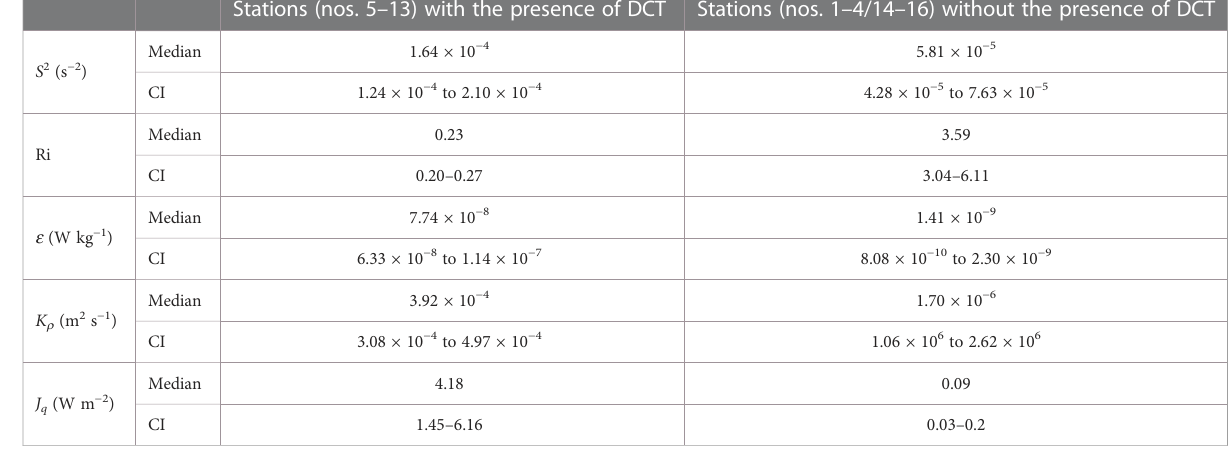
TABLE 1 Median values and 95% bootstrapped con fi dence intervals (CI) of shear variance ( S 2 ), Richardson number (Ri), TKE dissipation rate ( e ), diapycnal diffusivity ( K r ), and turbulent heat fl ux ( J q ) over 0 – 10 m below the base of the mixed layer for the stations with and without the presence of deep cycle turbulence